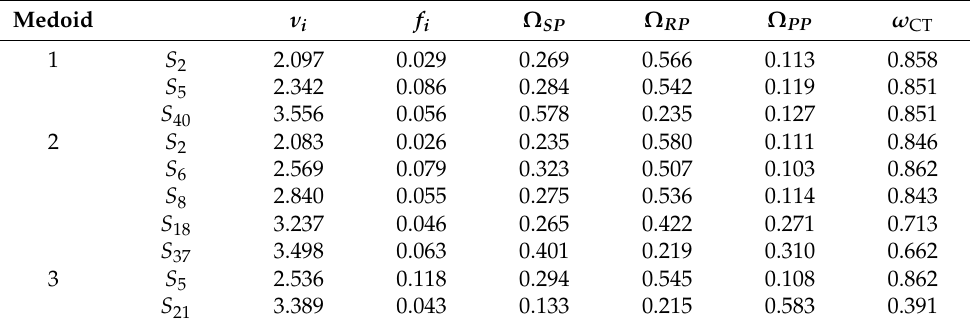
(please refer to Section 3.4 for definitions). Fragment labels: S: (NCS) 2 , R: Ru, P: (dcbpy) 2